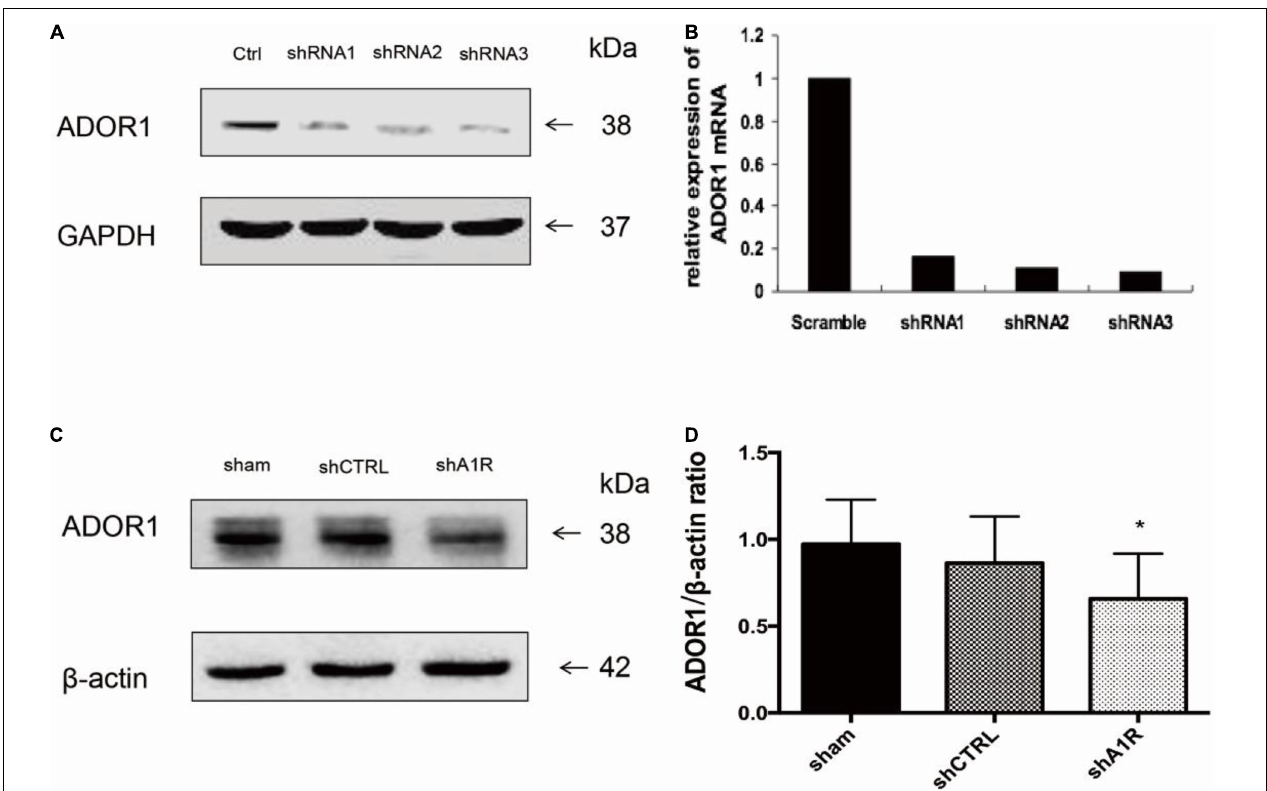
FIGURE 6 | Effect of AV-shRNA on the nerve cells of rats 48 h after administration of AV-shA1R. (A,B) Western blot analysis for adenosine receptor 1 (A1R) protein expression and PCR shows A1R mRNA expression ( n = 3). (C,D) A total of 48 h after administration of AV-shA1R and AV–shCTRL on the rats, Western blot analysis for A1R protein expression. * P < 0.05 vs. the sham